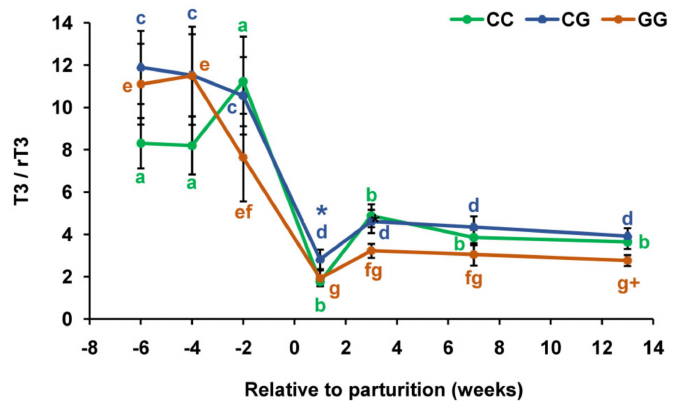
Figure 6. Total triiodothyronine to reverse triiodothyronine ratio (T3/rT3) during the prepartum and postpartum periods in the serum of dairy cows with polymorphic variants of the DIO1 gene. Means with different letters differ significantly within each group (at least p < 0.05). * p < 0.05 (between CC